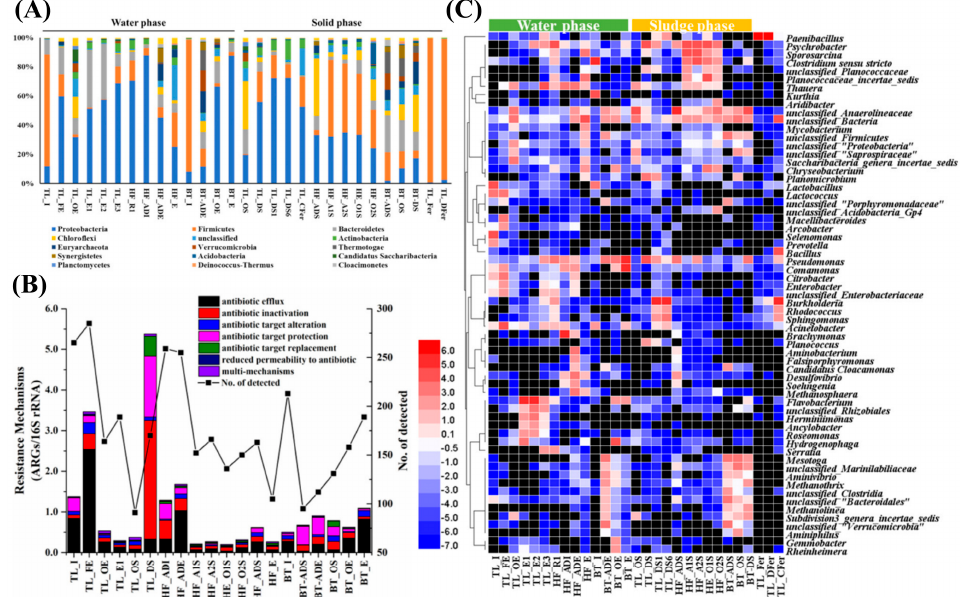
Figure 2. Microbial community composition in the water phase and sludge phase at the phylum level ( A ); Changes in the relative abundance of antibiotic resistance mechanisms and the number of ARGs detected at the subtype level ( B ); Heatmap of the top 10 genus in each sample (log 2 transformed) ( C ) [67].